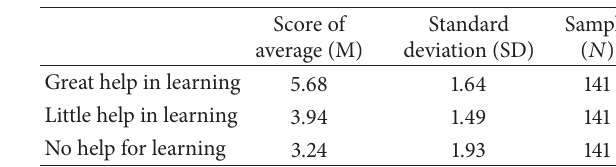
Table 2: Results of the